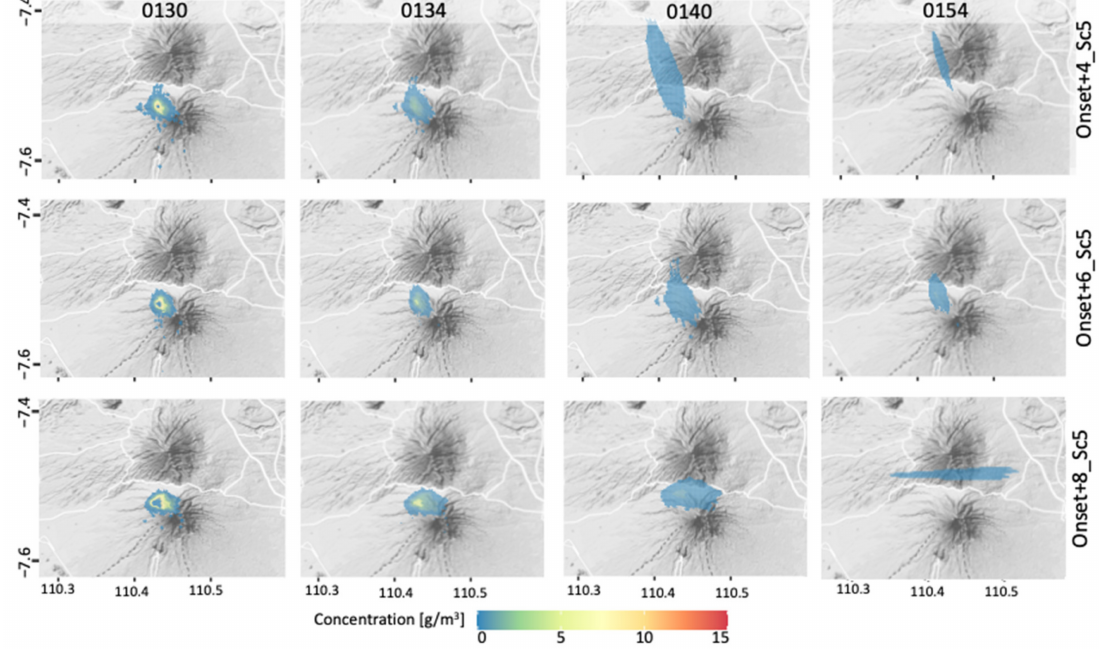
Figure A4. Some examples of the ensemble members (row) at different time step output (column). Presented is the nowcasting of M06. Each ensemble member was named based on the initial condition: onset+ i _Sc j , where i and j represent the time in minutes and advection scenario (Table 3), respectively. In each image, the x -axis is longitude and y -axis is